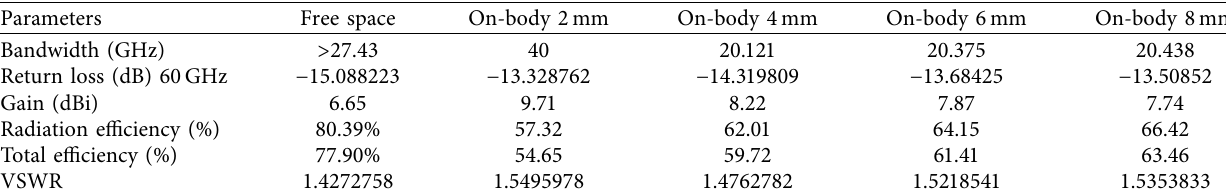
Figure 50: Radiation patterns of the 2 × 2 array antenna for different distances (a) on XY plane and (b) on YZ plane. Table 7: On-body comparison of the 2 × 2 array antenna for different